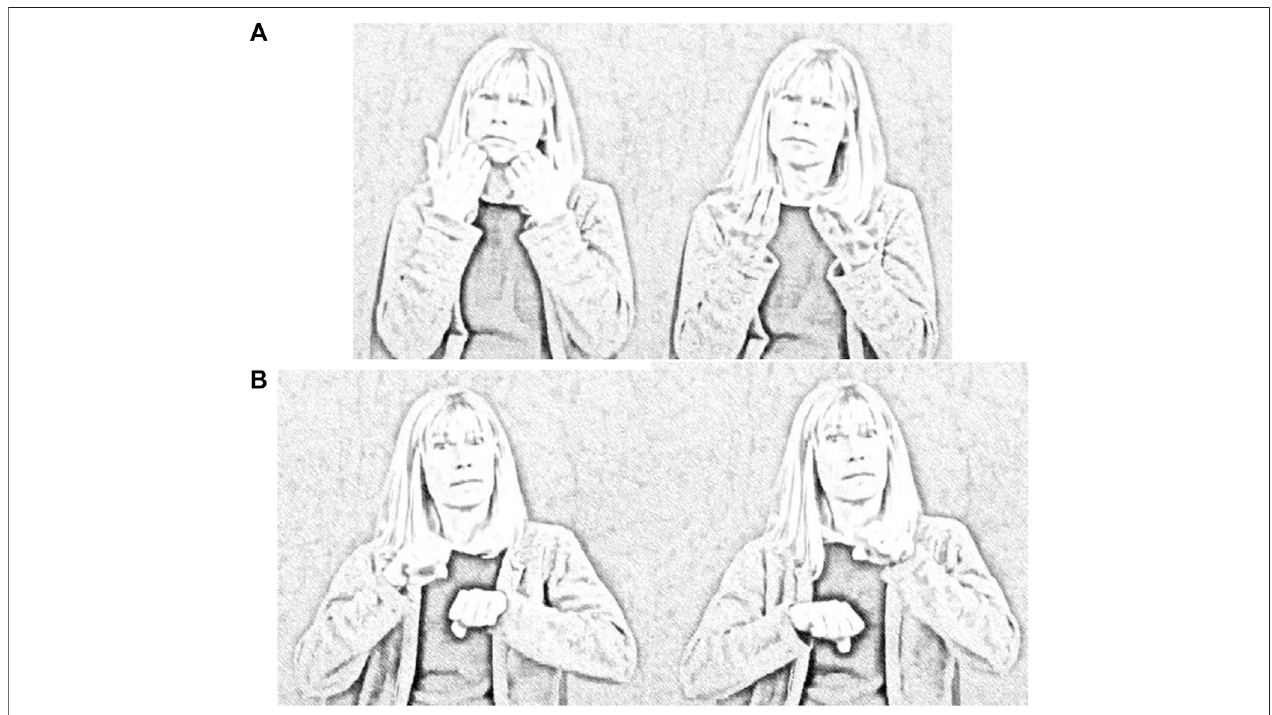
FIGURE 1 | Examples of two-handed balanced signs from ASL classi fi ed as symmetrical (A) or alternating (B) . (A) SHAME , is produced with a single movement of both handsmovingawayfromthesigner ’ sbody; (B) BICYCLE ,isproducedwithtwohandsmovinginarepeatedalternatingcyclicmotion(Wefollowthe fi eld ’ sconvention of glossing signs with small caps). Examples are from the online dictionary ASL-Lex (Caselli et al.